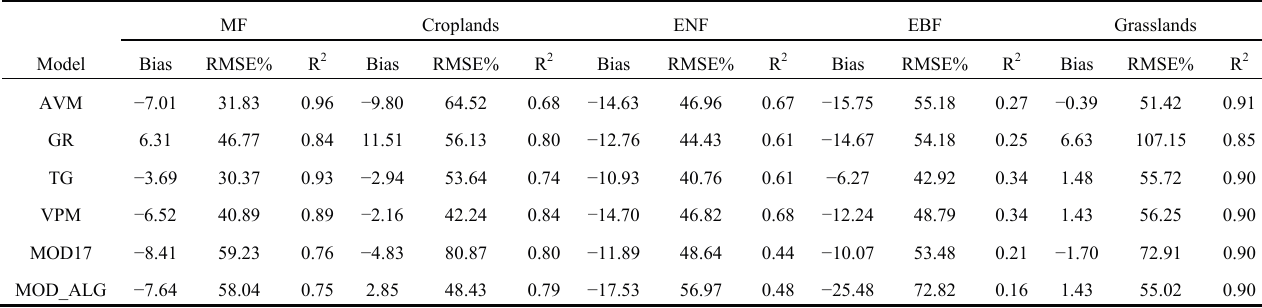
Table 5. Performance of AVM, GR, TG, VPM, MOD17, and MOD_ALG models over the study period. Unit of bias: gC/m 2